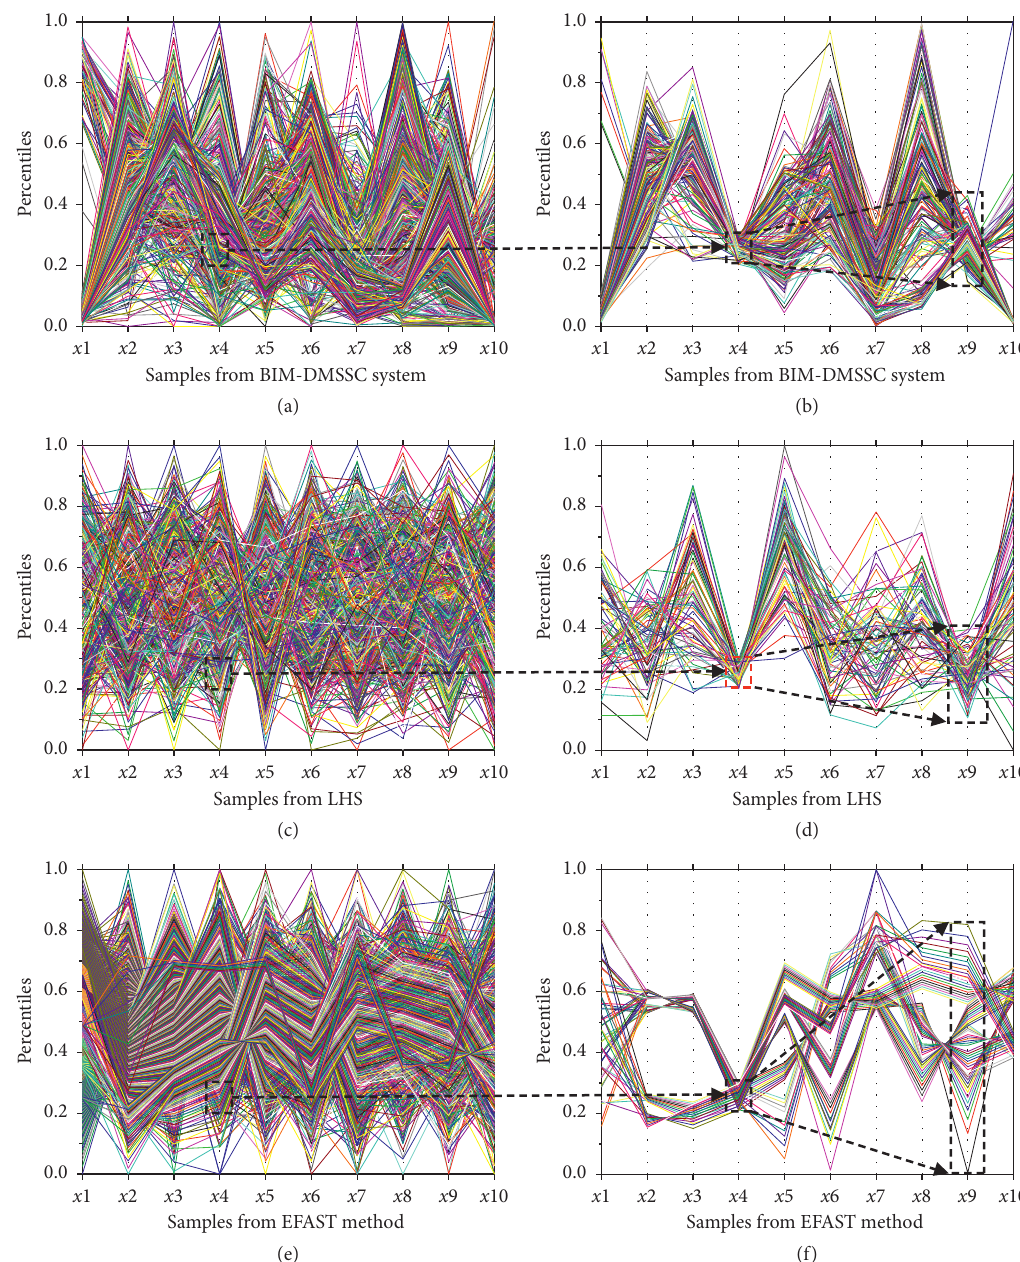
Figure 10: Parallel coordinates plot of samples from BIM-BDP data, LHS, and eFAST method: (a) samples from BIM-BDP; (b) samples from BIM-BDP with x 4 varying from 0.2 to 0.3; (c) samples from LHS; (d) samples from LHS with x 4 varying from 0.2 to 0.3; (e) samples from eFASTmethod; (f) samples from eFASTmethod with x 4 varying from 0.2 to 0.3. If parameter lines of x 4 varying from 0.2 to 0.3 cover the entire range of a parameter, for instance, lines on x 9 in (f), the correlation coefficient is low. If they concentrate in a subrange, for instance, x 9 in (b) and (d), the correlation coefficient is